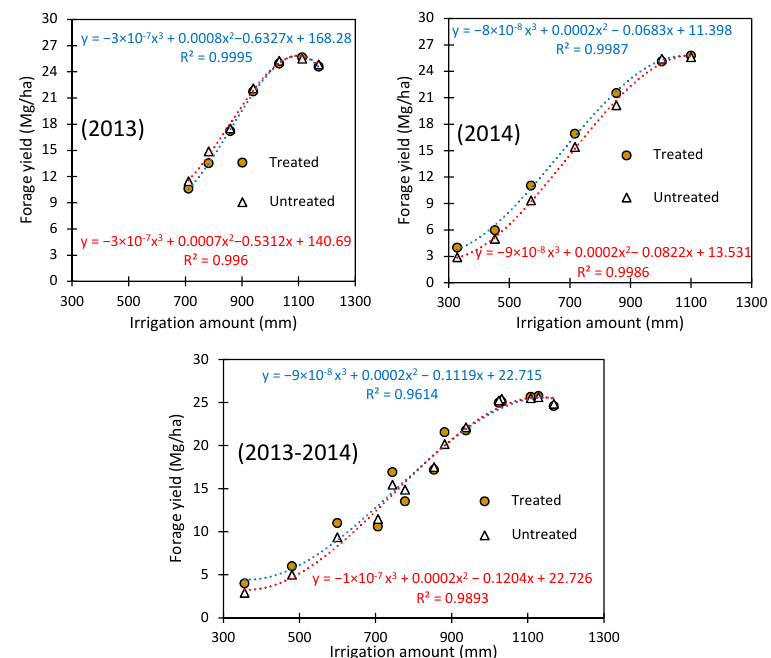
Figure 4. Annual forage yield as a function of irrigation amount in the 2013 and 2014 growing seasons and on average for 2013–2014. Table 1. Summary of the analysis of variance (ANOVA) of the 2012–2014 alfalfa experiment.